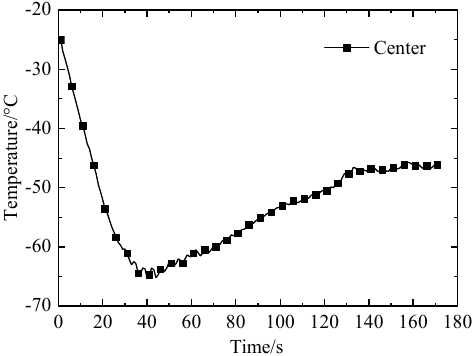
Figure 7. The temperature response curve of the central point under 0.4 Mpa without heating.